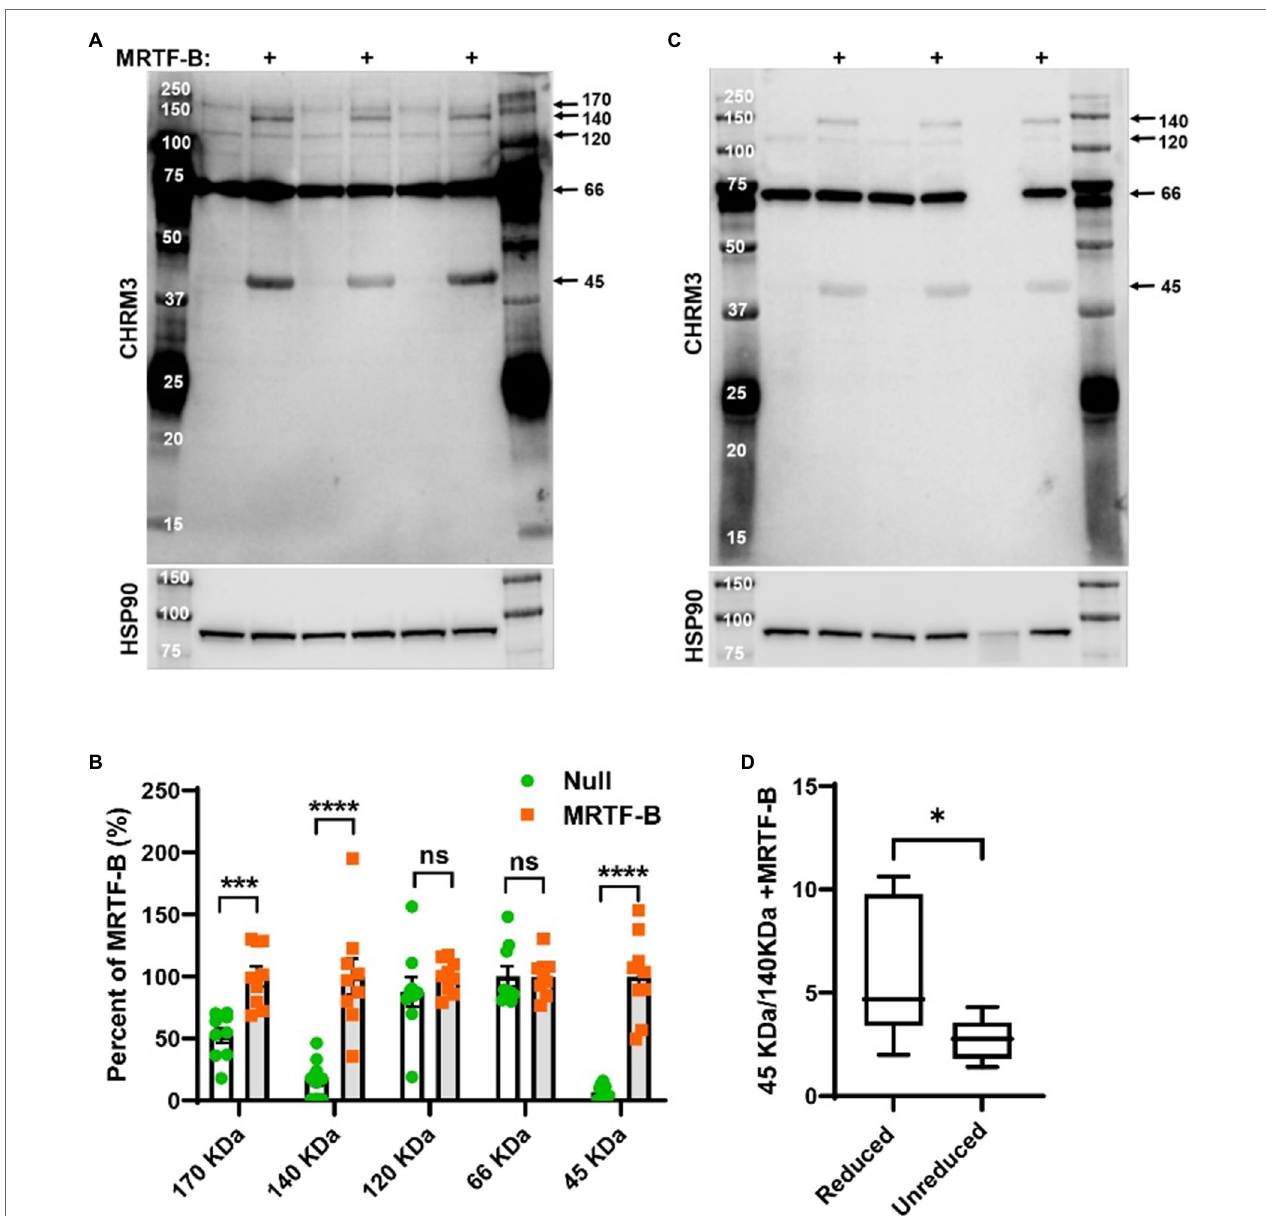
FIGURE 4 | MRTF-B increases CHRM3 immunoreactive bands in human coronary artery smooth muscle cells. Protein lysates from human coronary artery SMCs treated with null virus and with MRTF-B virus for 120 h, respectively, were used for Western blotting using an antibody raised against a human CHRM3 in (A) . After developing the blot, it was stripped and incubated with HSP90 antibody (shown below) to assess equal protein loading. At least five bands were detected with the CHRM3 antibody, and three bands at ≈ 170, ≈ 140, and ≈ 45 kDa changed significantly with MRTF-B as shown in the compiled analysis in (B) . Quantification in panel (B) was done using the blots in (A) . Proteins from the same original lysates were also prepared in non-reducing conditions, to examine if the relationship between bands changed (C) . The volume was insufficient for one of the null samples in this experiment (lane 6). Non-reducing conditions favored the 140 kDa band at the expense of the 45 kDa band (D) , suggesting multimerization. **** p <0.0001, *** p <0.001, and * p <0.05